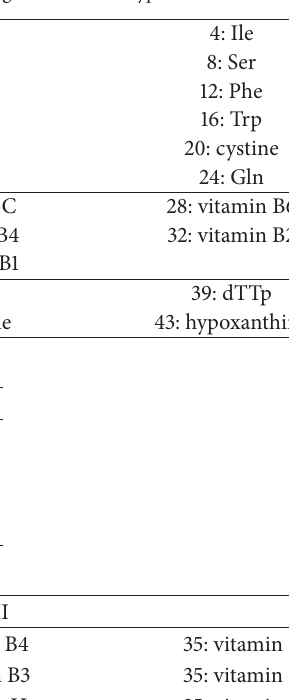
Table 3: Different combination groups of growth factors used in this work to determine the auxotrophic phenotype of the four mutation